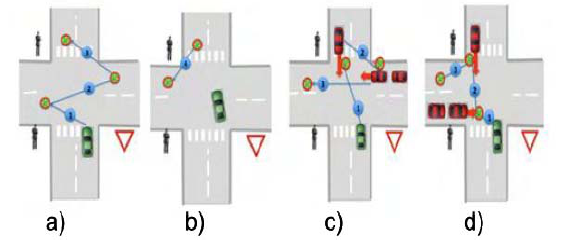
Fig. 5 Typical look sequence in Scenario 6 for: a) Drive through if no other road users exist, b) Bending if no other road users exist, c) Drive through with oncoming and traffic crossing from the right, d) Drive through with oncoming and traffic crossing from the